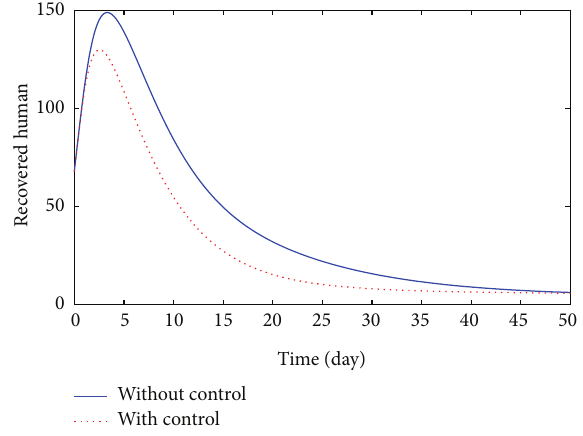
Figure 4: The plot shows the population of recovered human with and without